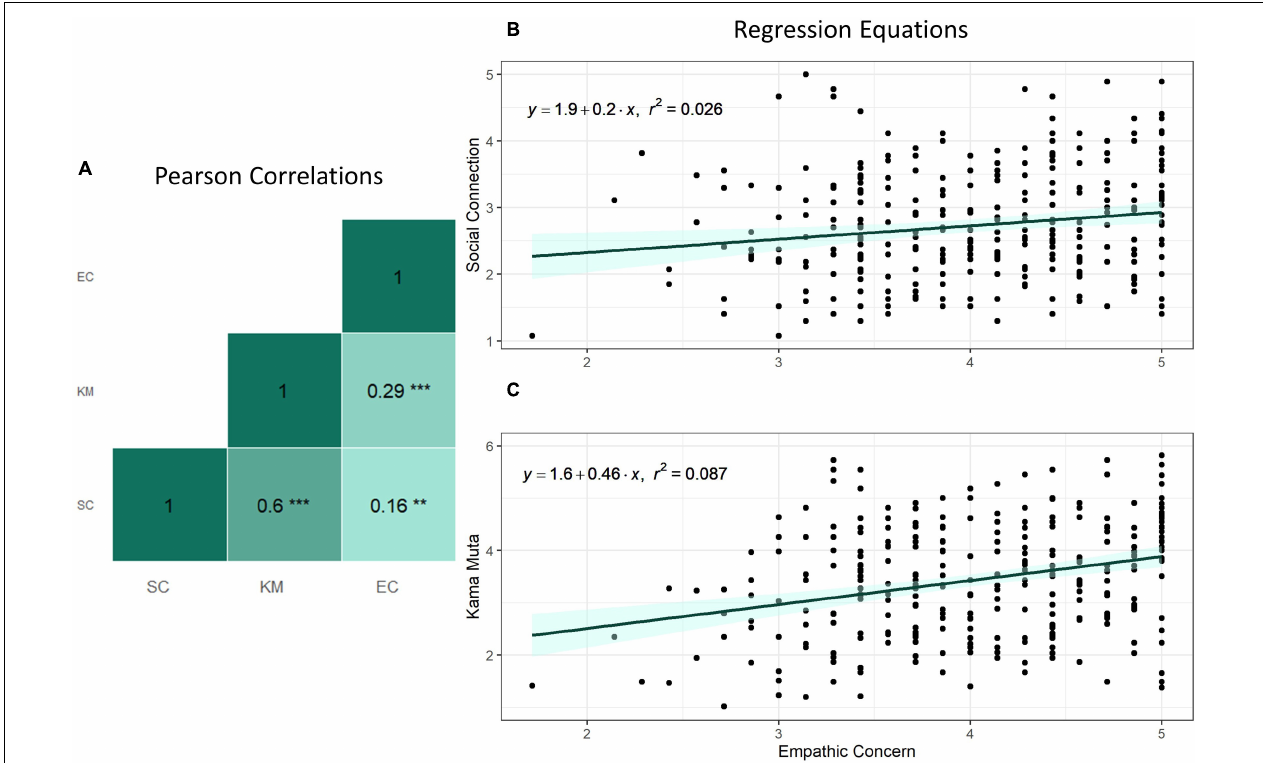
FIGURE 1 | The relations between empathic concern, social connection, and kama muta with (A) correlations and regression equations of (B) social connection and (C) kama muta . ** p < 0.01, *** p < 0.001.